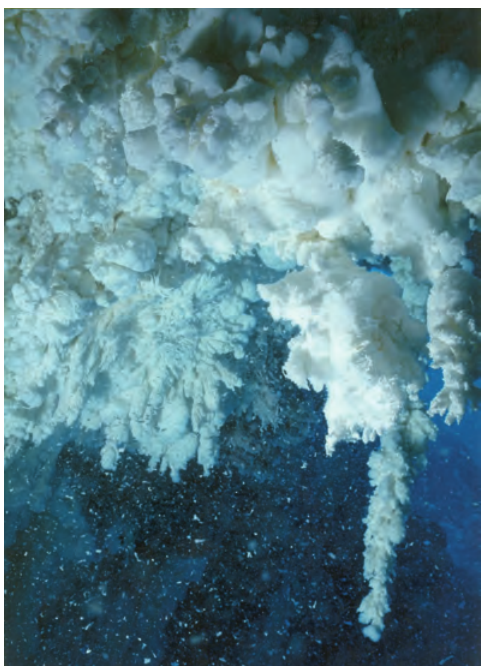
Fig. 2. Mat deposit at the C7 sampling site. The presence of a rocky wall as support allowed the large formation of thick, soft and white mat deposits main- ly composed by